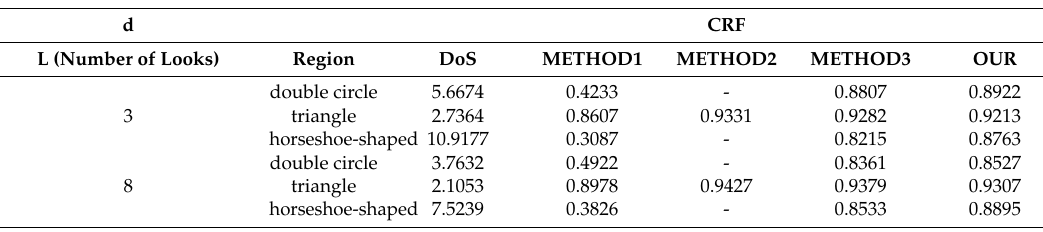
Table 1. DoS (difficulty of segmentation) and CRF (cross-region fitting) for the simulated SAR image in Figure